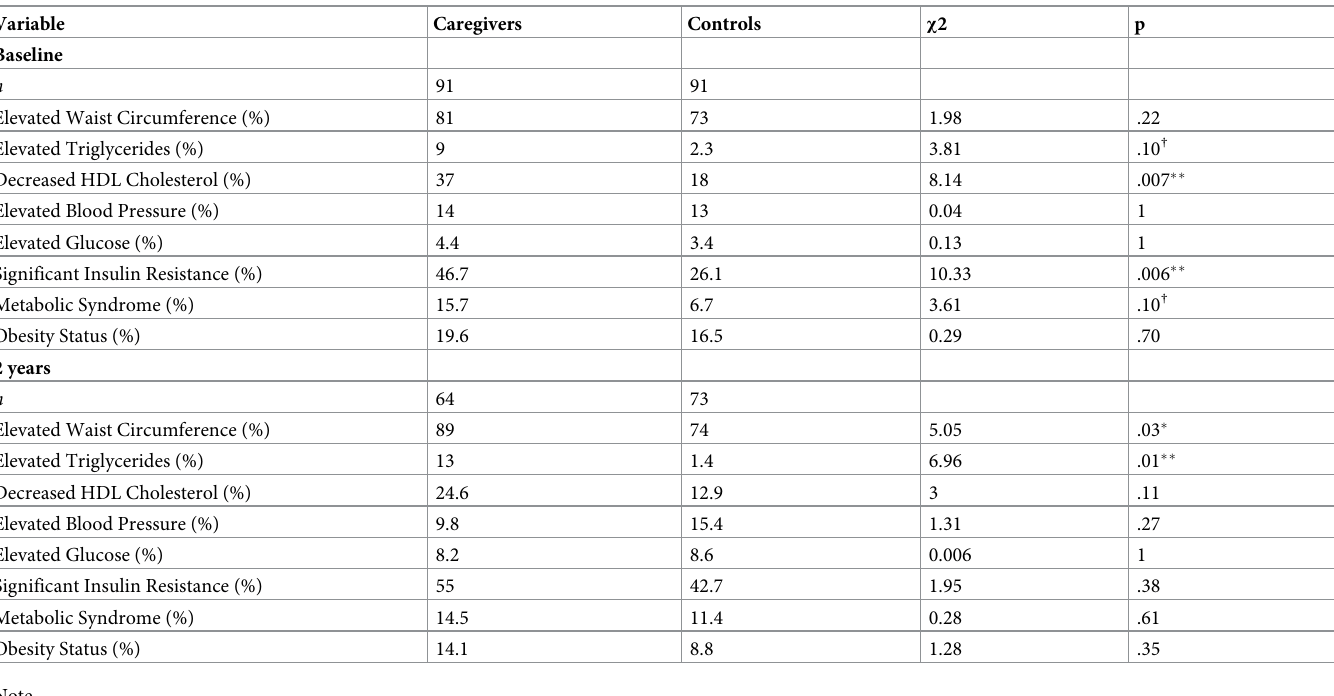
Table 5. Group differences in metabolic health using IDF clinical-cut off criteria [43].